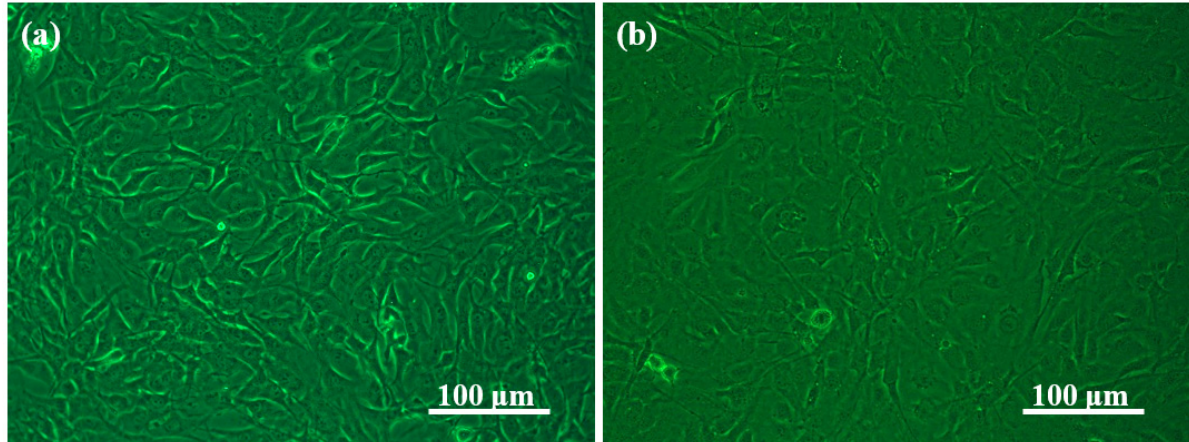
Figure 8. Optical micrographs of ( a ) osteosarcoma MG-63 cells and ( b ) osteoblastic MC3T3-E1 cells cultured on the tissue culture polystyrene.